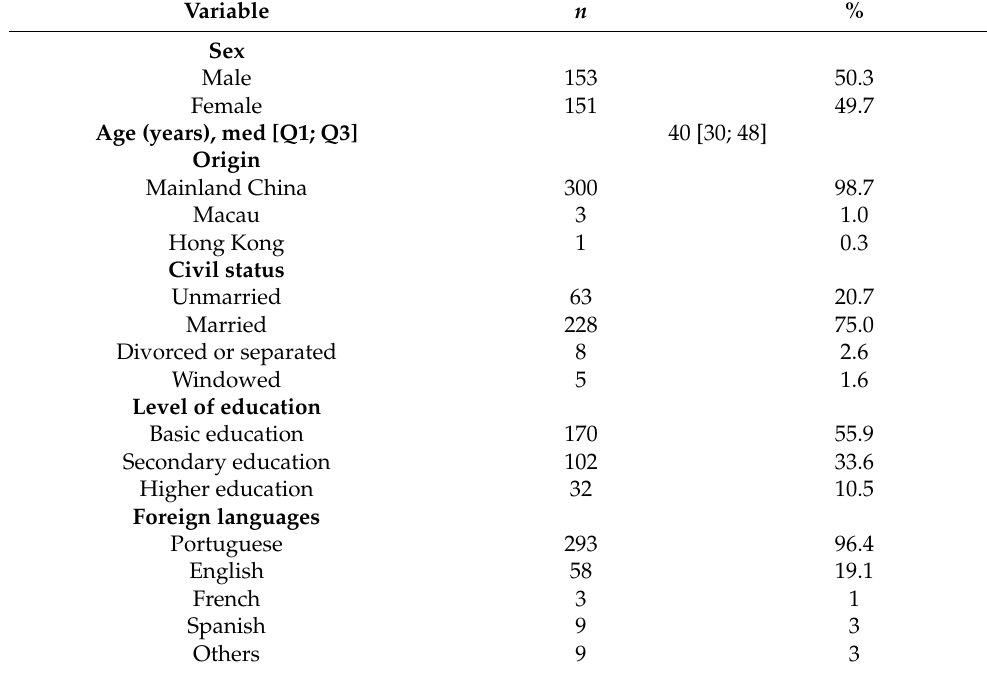
Table 1. Characteristics of the participants ( n =